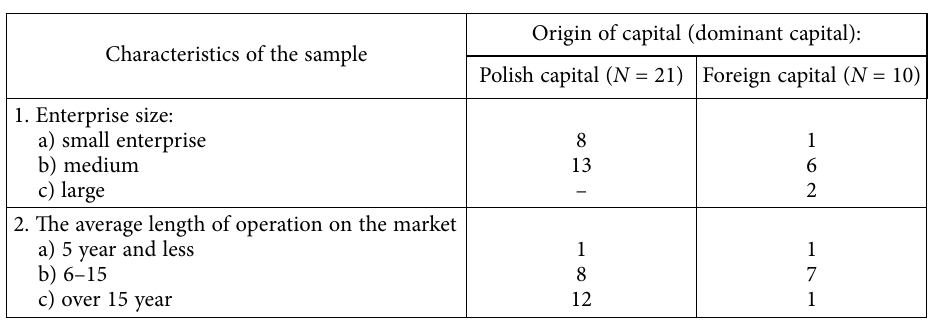
Table 3. Main characteristics of the sample Characteristics of the sample